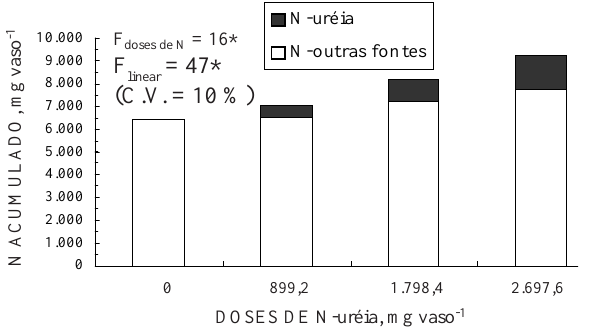
Figura 4. Nitrogênio acumulado na cana-planta, derivado do N-uréia e de outras fontes (os valores de teste F e de C.V. referem-se à planta toda).